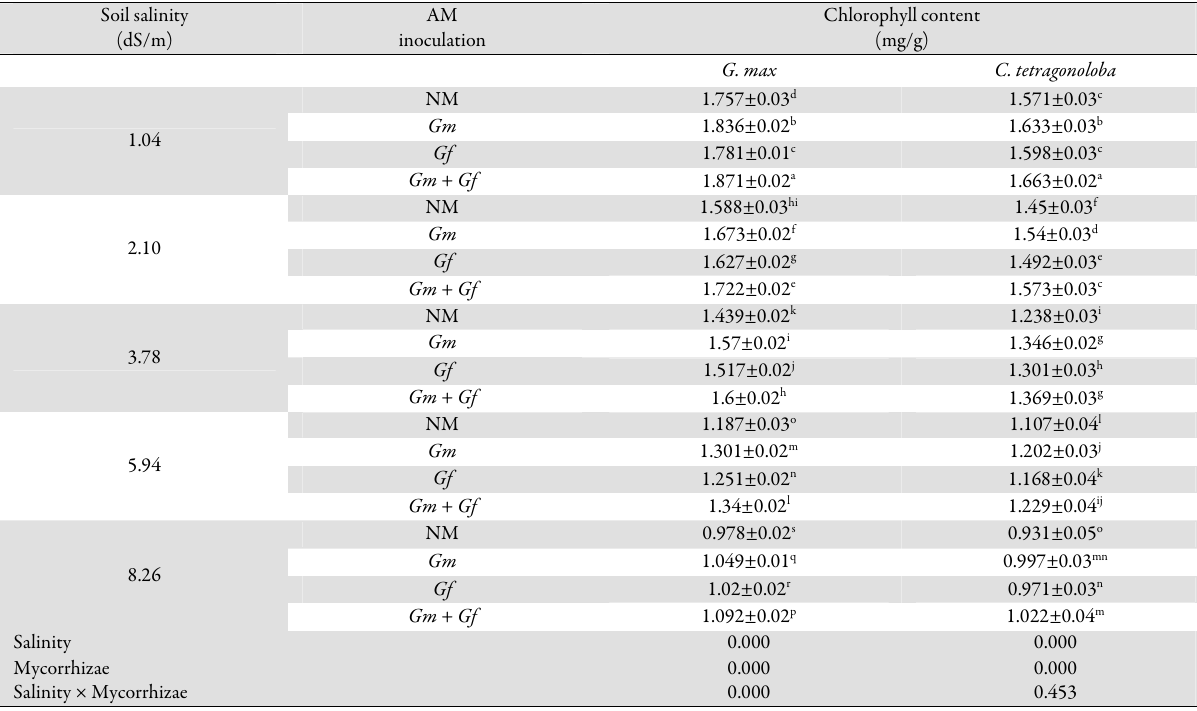
Tab. 1. Dry weight (g/plant) of mycorrhizal and non-mycorrhizal G. max and C. tetragonoloba grown under control (1.04 dS/m) and at increasing soil salinity levels (2.10 to 8.26 dS/m)